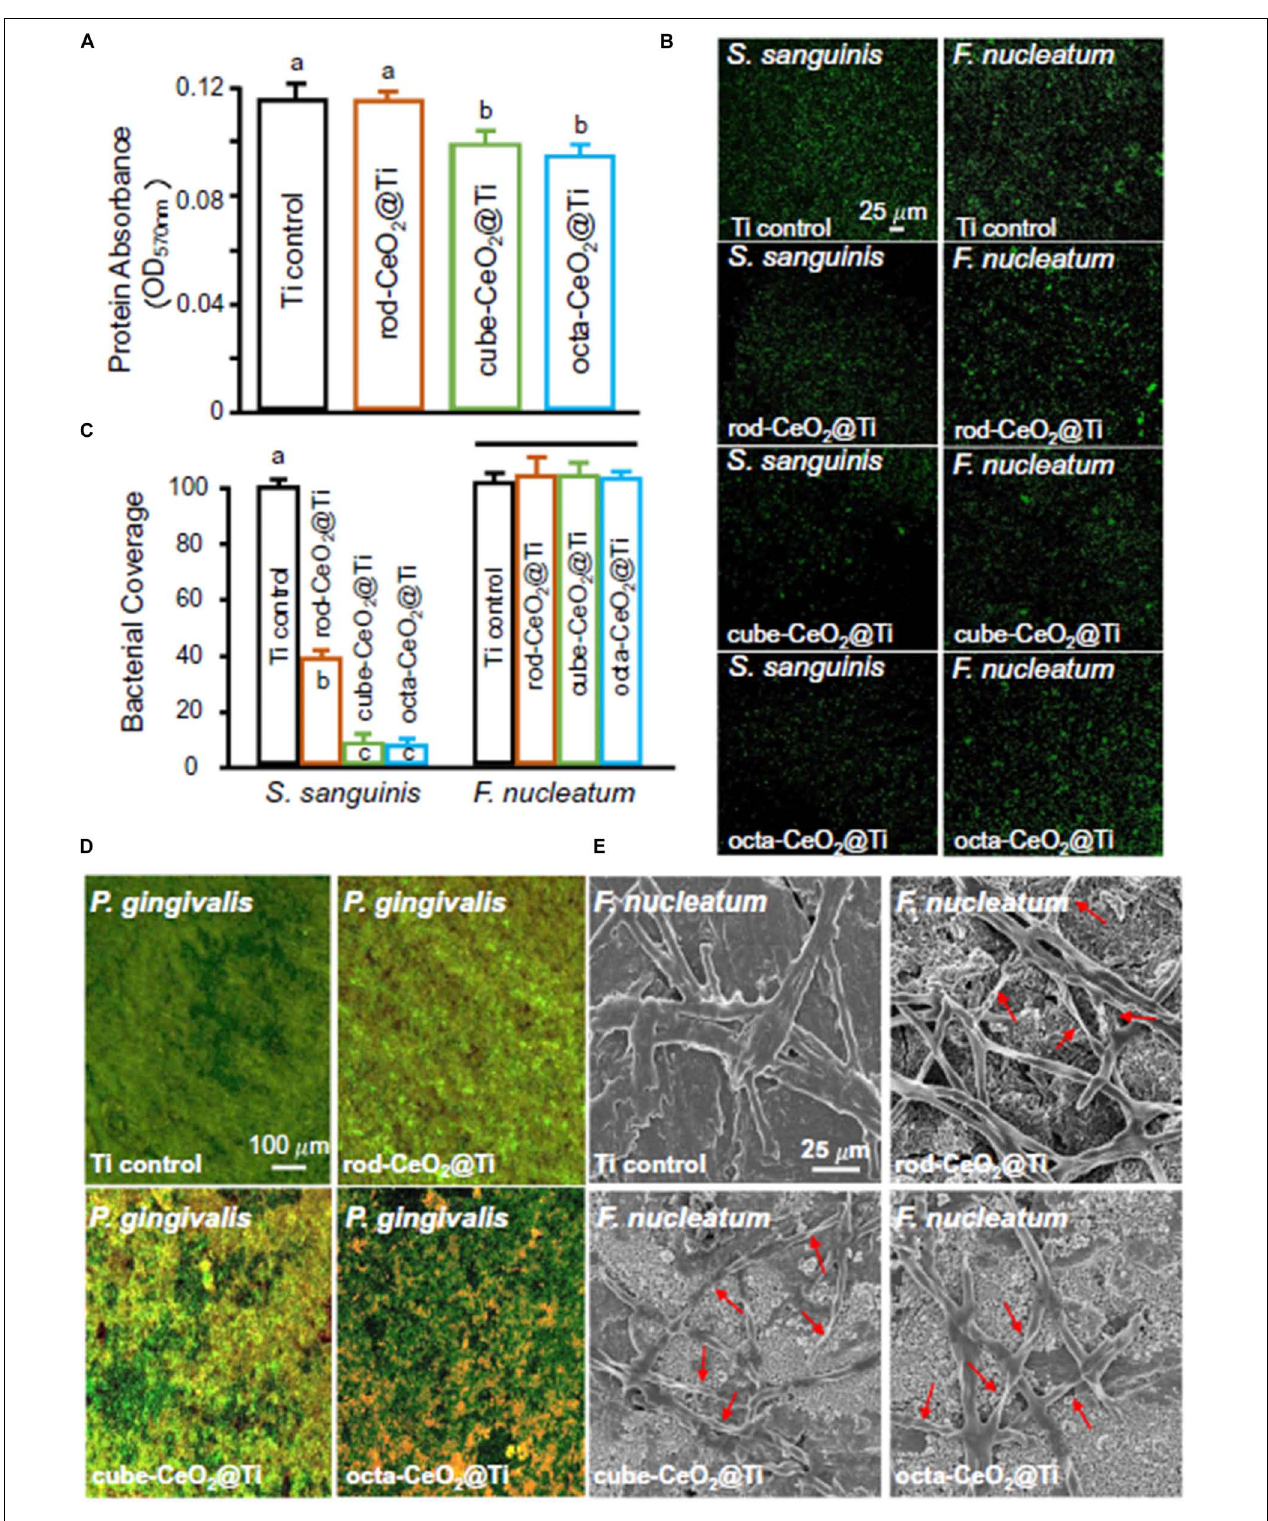
FIGURE 6 | The antibacterial properties of three different types of CeO 2 -modified Ti. (A) Protein adsorption onto different surfaces ( n = 6; mean ± SD). Dissimilar letters indicate values that are significantly different from each other ( p < 0.05). (B,C) CLSM images and area cover fractions of S. sanguinis and F. nucleatum early colonization onto Ti at 4 h ( n = 6; mean ± SD). Ti control was equal to 100%, and other groups were a percentage of Ti control. The solid line indicates that there